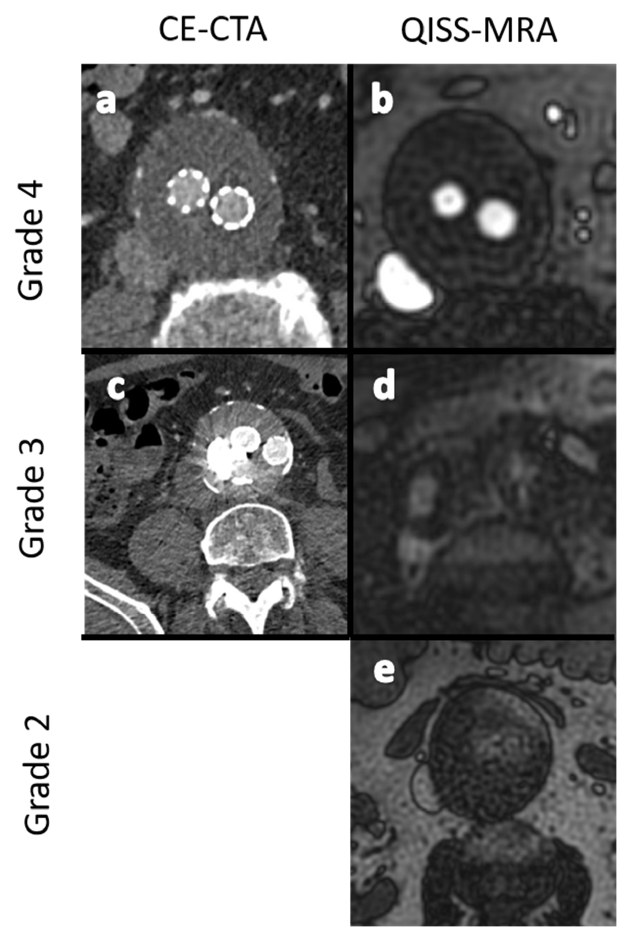
Figure 3. Exemplary images for the grading of image quality in grades 2 to 4. ( a , b ): ‐ Excellent image quality (grade 4). ( c , d ): Minor inhomogeneities affecting the outlining of the vessels (grade 3). ( e ): Ill ‐ defined vessel ‐ borders with suboptimal image quality for diagnosis (grade 2). No dataset showed nondiagnostic image quality (grade 1).